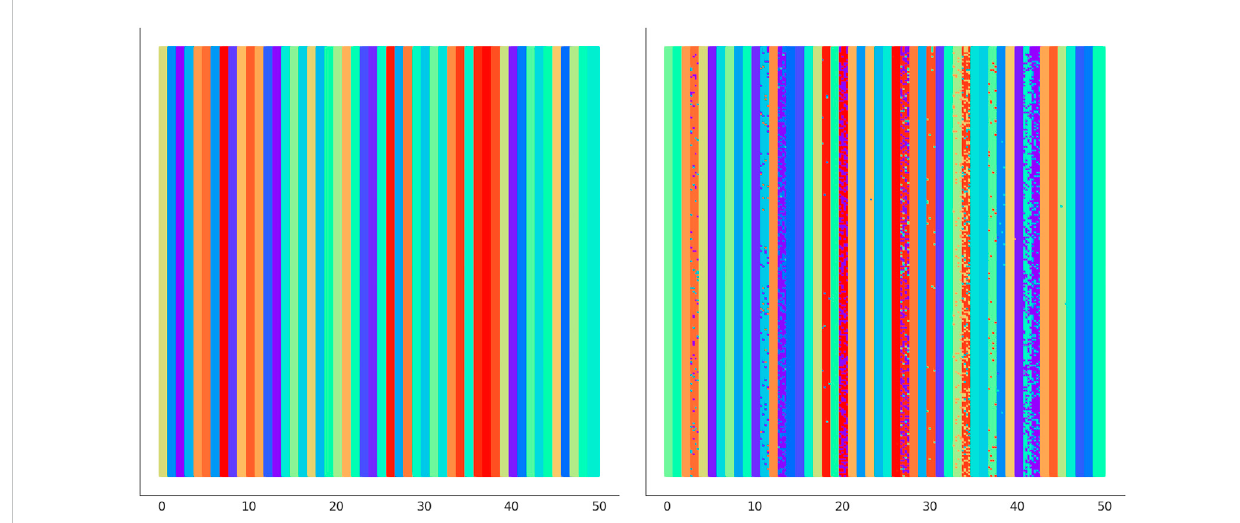
FIGURE 7 (Left)GoldstandardclusteringwhereeachbarcorrespondstoallthesignalspertainingthesameBCindataset D 1 .(Right)Clusteringoutcomewhere the signals are colored according to the result achieved with UNPLEX, non-uniform coloring in a bar indicates the presence of misclustered signals.